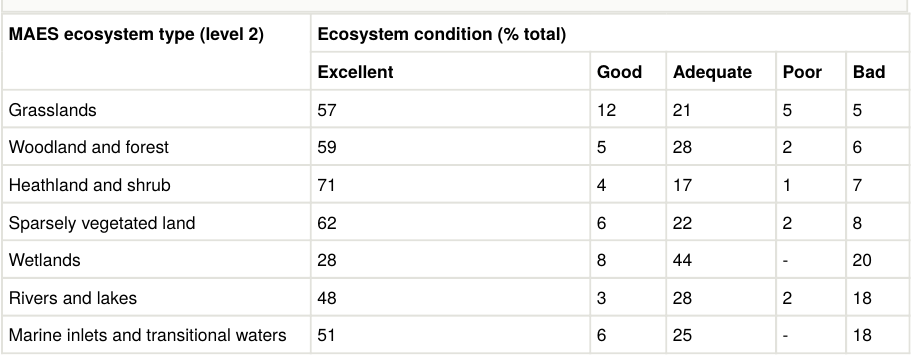
Proportion (%) of the ecosystem condition categories assigned to the ecosystem types (MAES level 2) of Greece (EEA 10 km grid cell analysis). The ecosystem condition is scaled as: Excellent, Good, Adequate, Poor and